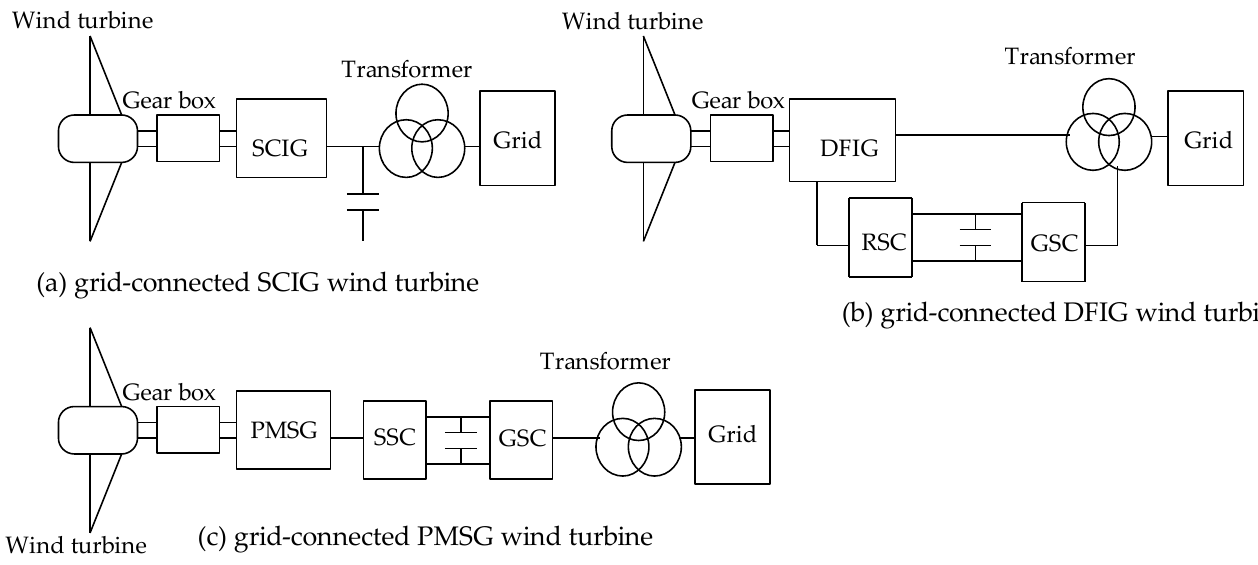
Figure 2. General topologies for grid-connected three different types of wind turbine generators.